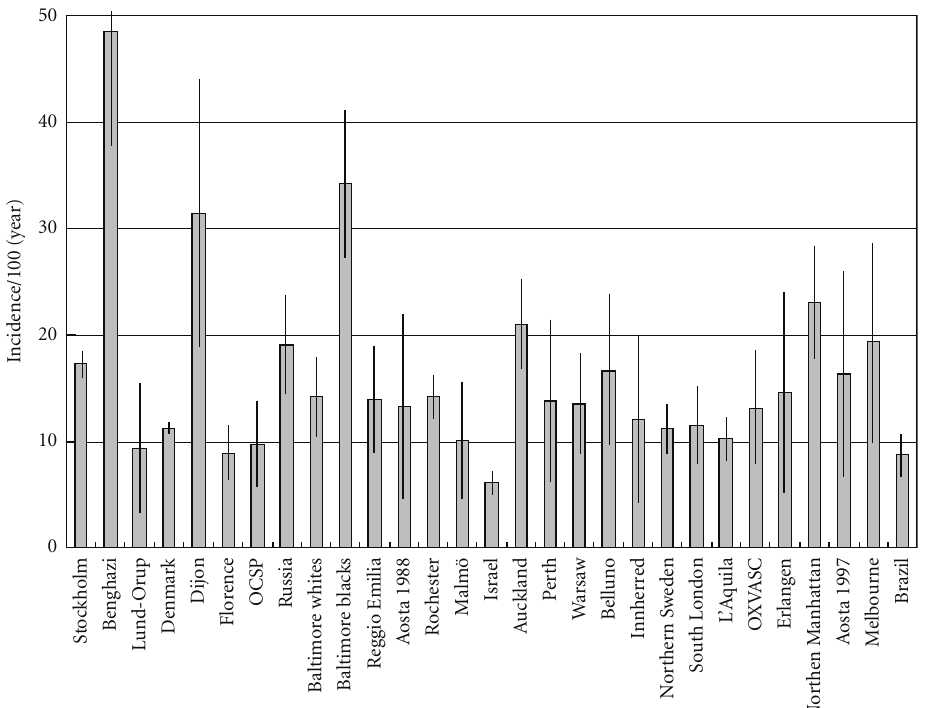
Figure 1: Incidence rates of stroke in the young (rates are adjusted for age and sex to the 2000 European